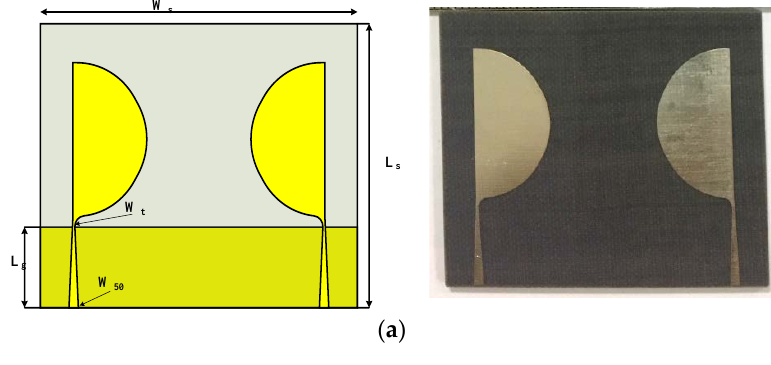
Figure 4. The simulated S-parameters ( a ) S11 and ( b ) S12.